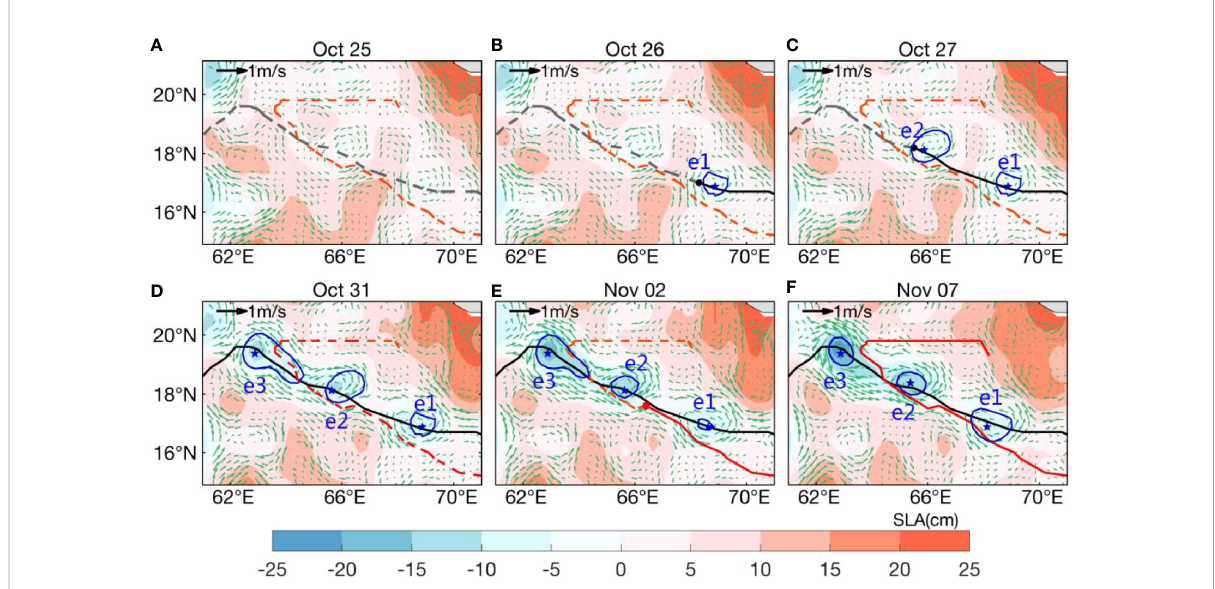
FIGURE 8 Observations of SSHAs (colours: cm) and geostrophic velocity of zonal/meridional components (arrows: m/s) before , during and after the passage of the two TCs. (A) : before Kyarr, (B, C) : during Kyarr, (D) : after Kyarr and before Maha, and (E) : after Kyarr and during Maha. (F) : after Kyarr and Maha. The solid blue lines show the shape of eddies, and the blue fi ve-pointed stars show the centre of the eddies. The expression of the TC tracks is the same as that in Figure 3. The black boxes represent three typical regions with obvious SSHA decreases and sea surface cooling, as shown in Figure